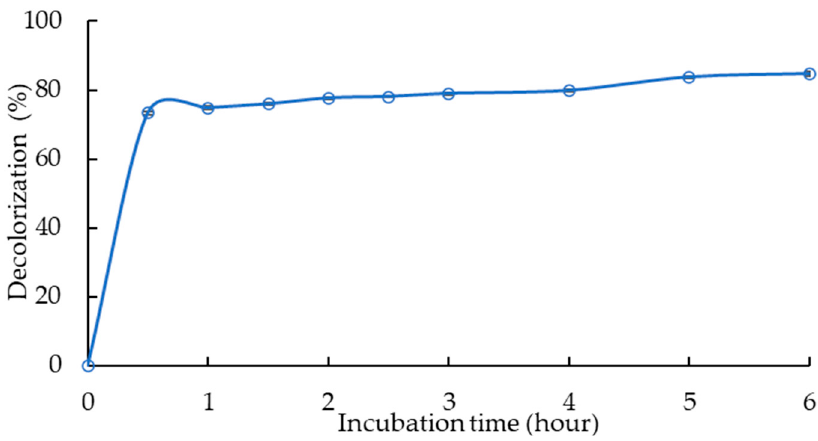
Figure 5. Kinetics of RB5 decolorization as a function of incubation time.